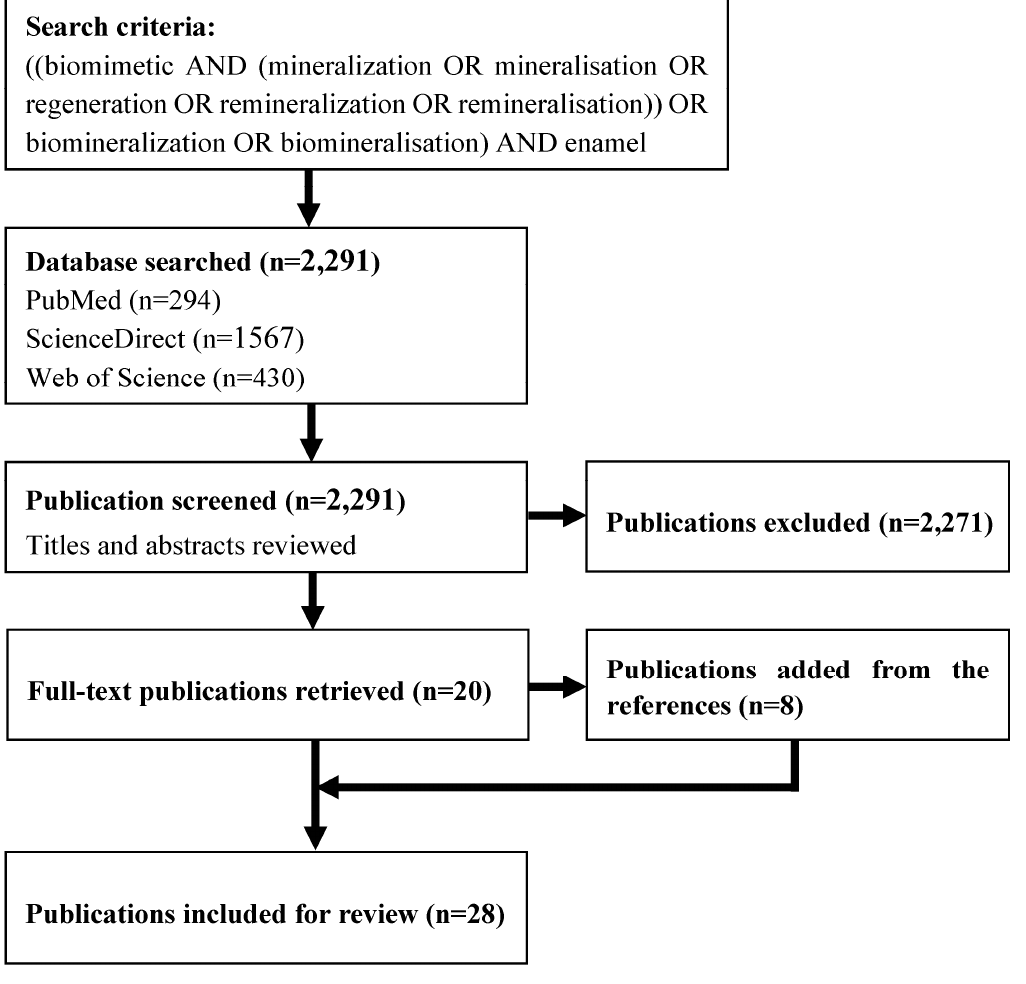
Figure 1. Flowchart of the search